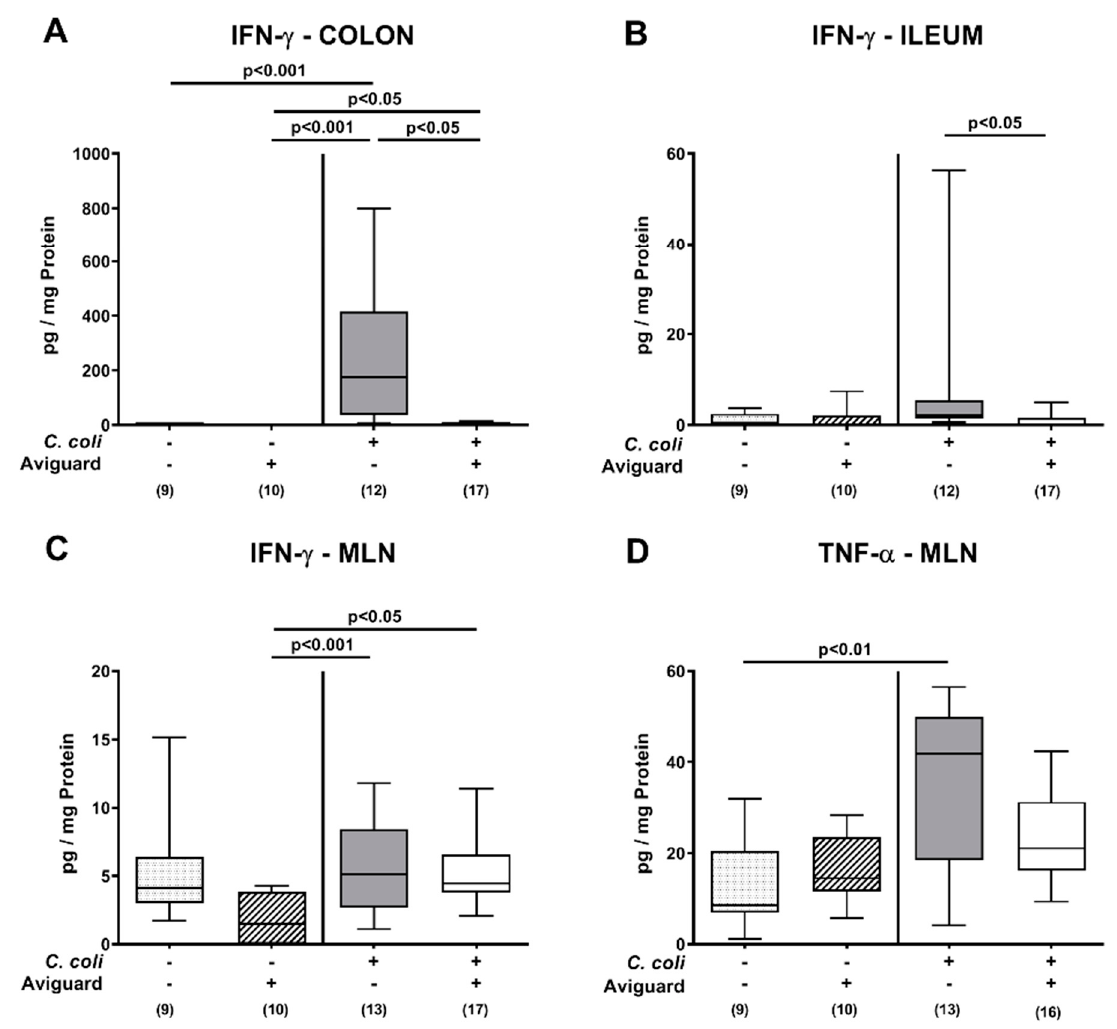
Figure 6. Intestinal secretion of proinflammatory cytokines following peroral Aviguard ® treatment of C. coli- infected secondary abiotic IL-10 − / − mice. Mice were infected with a C. coli patient isolate on day (d) 0 and d1 by gavage. On d2, d3 and d4 post-infection (p.i.), mice were perorally challenged with the probiotic formulation Aviguard ® (white boxes) or received placebo (gray boxes). On d6 p.i., intestinal IFN- γ concentrations were measured in ex vivo biopsies derived from the ( A ) colon, ( B ) ileum and ( C ) mesenteric lymph nodes (MLN). Furthermore, ( D ) TNF- α concentrations were determined in MLN. The box plots indicate the 25 th and 75 th percentiles of the medians (bar within boxes). Total range, significance levels ( p values) calculated by the Kruskal–Wallis test and Dunn’s post-correction and numbers of analyzed mice (in parentheses) are indicated. Outliers were excluded after identification by the Grubb’s test ( α = 0.001). Pooled data were derived from four independent experiments. +, with; − , without.